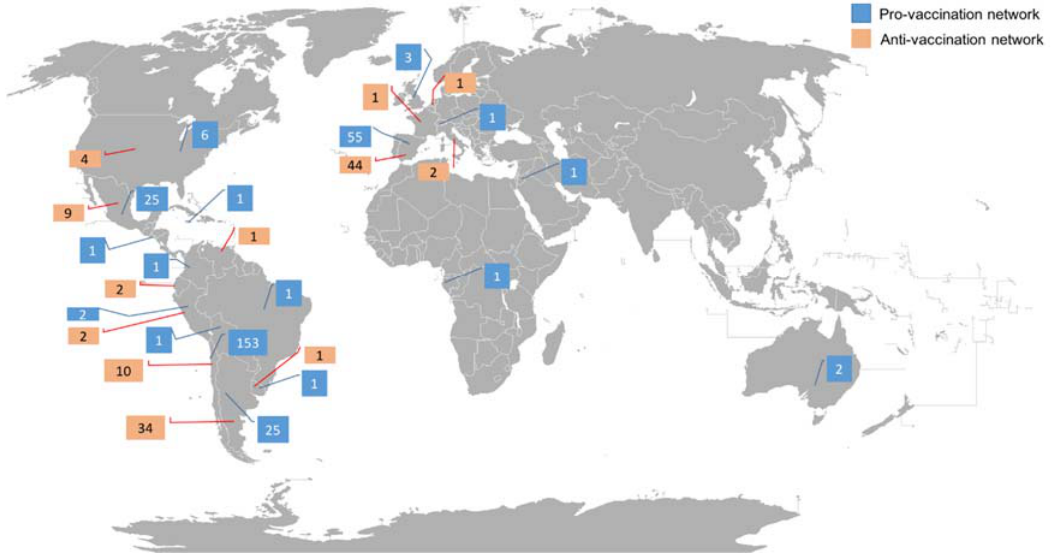
Figure 2. Bots’ location on pro and anti-vaccination networks. (Figure adapted from Fobos92 ′ s world map with CC BY-SA 3.0